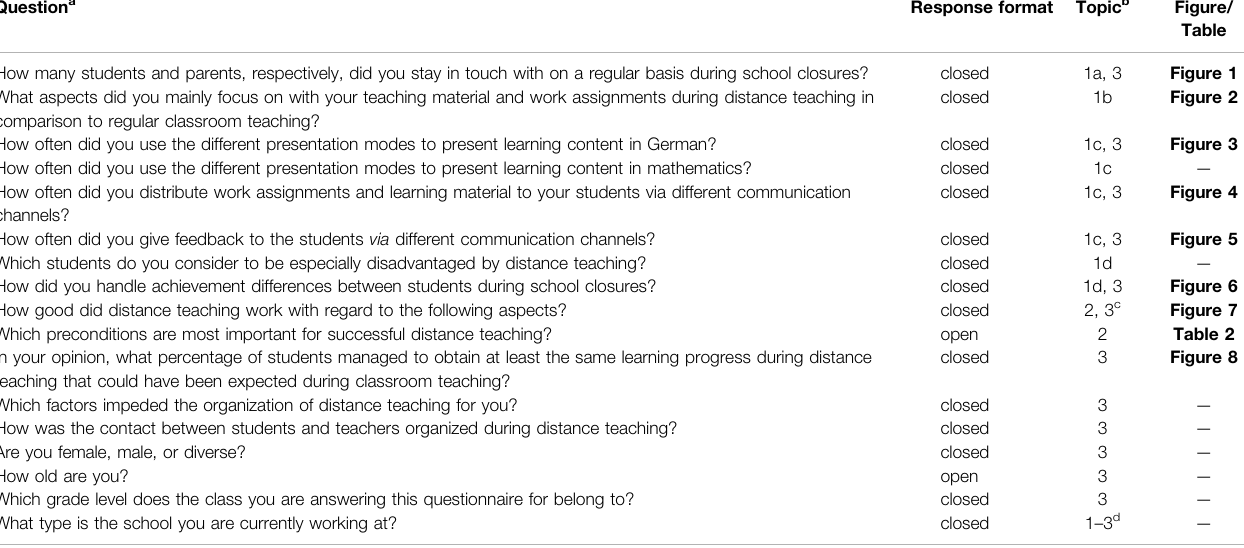
TABLE 1 | Questionnaire content